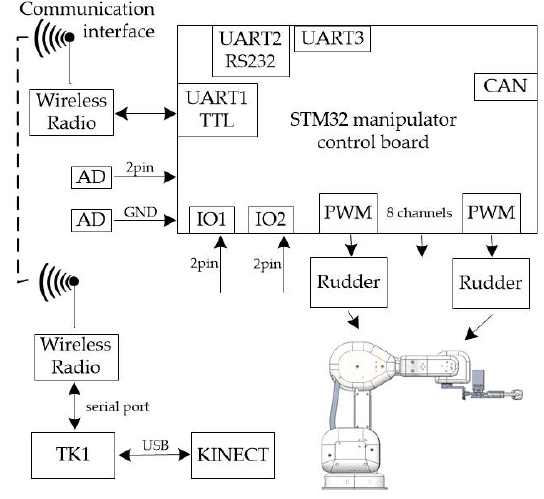
Figure 3. The structure of the control box.